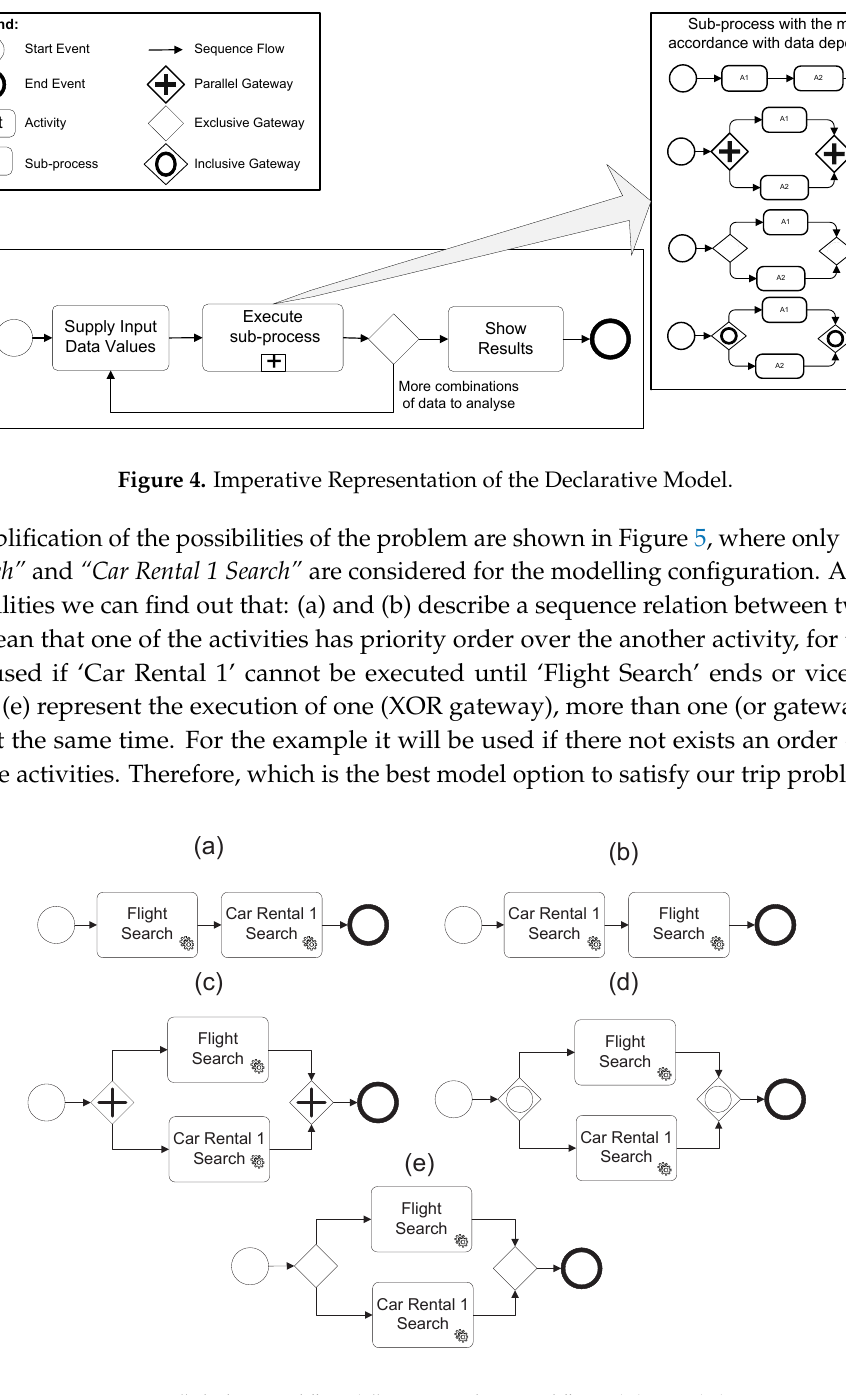
Figure 5. “Flight Search” and “Car Rental 1 Search” Model